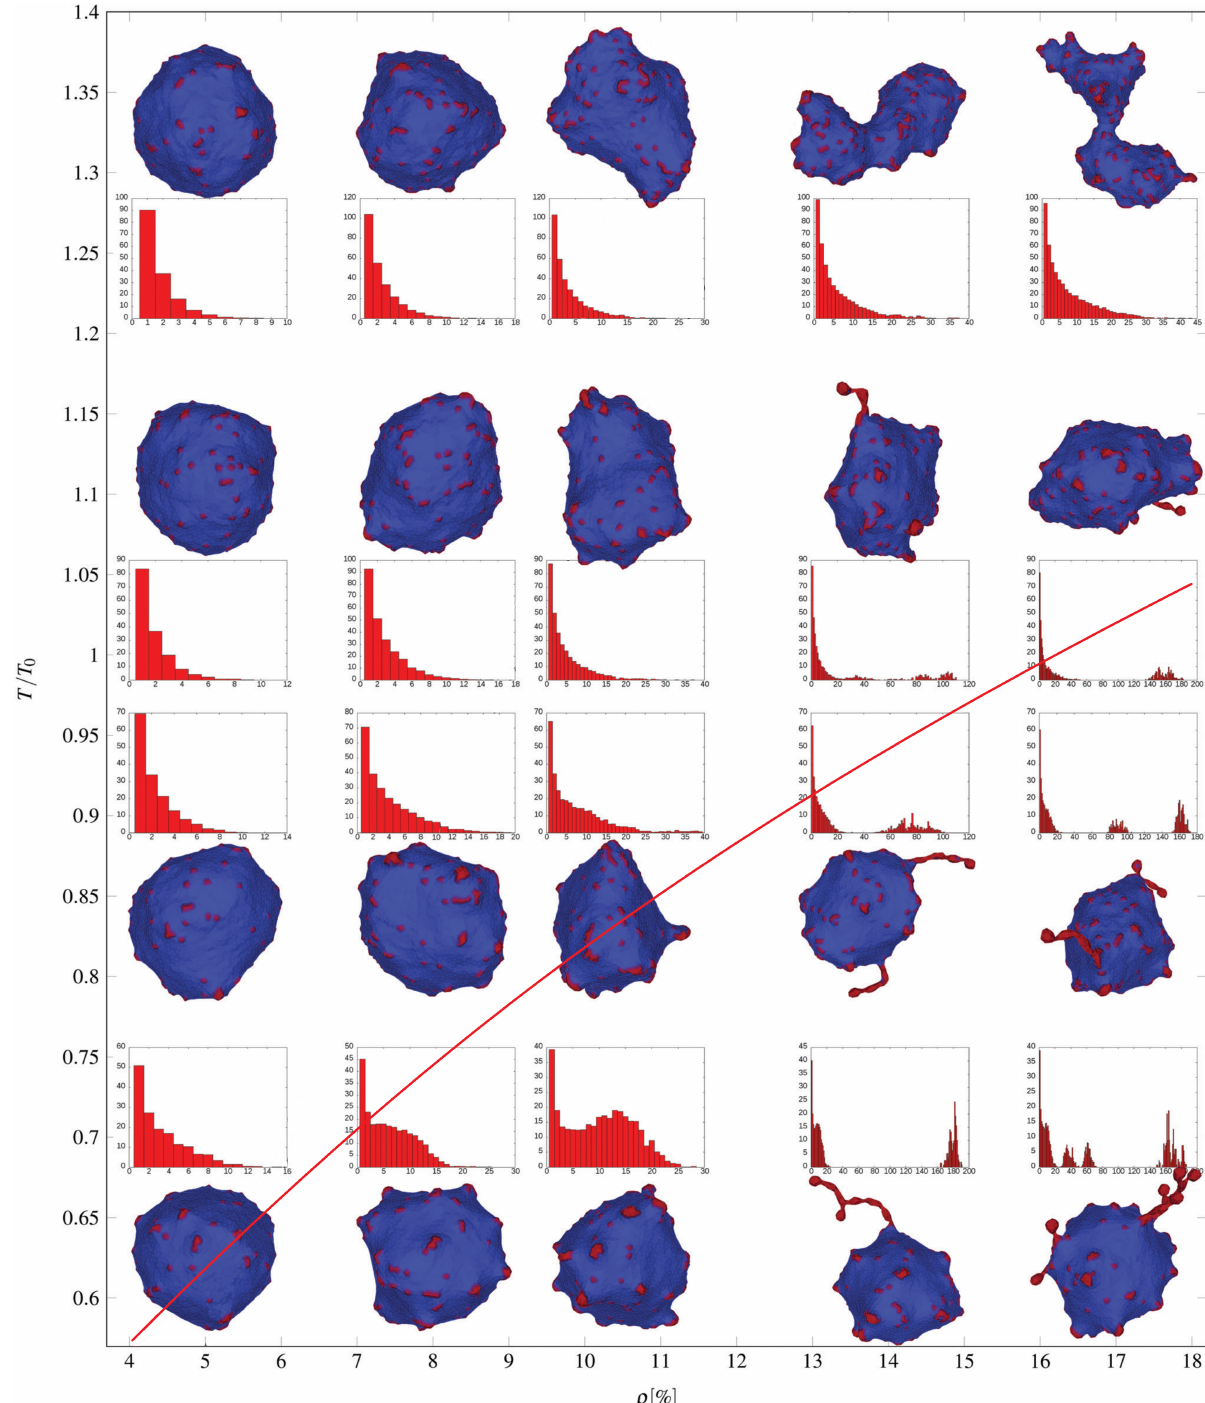
Figure 17. Monte-Carlo (MC) predicted vesicle shapes in thermal equilibrium with curved flexible nanodomains. The dia- gram provides information for differing average densities of curved nanodomains ρ and relative temperatures T / T 0 . Blue surfaces represents the nanodomain-free lipid bilayer and has zero intrinsic (spontaneous) curvature; red surface denotes the curved nanodomain clusters with spontaneous curvature c 0 . In the corresponding cluster-size distributions below each snapshot, the y -axis is the ensemble averaged number of nanodomain clusters and the x -axis is the nanodomain cluster size. The red curve is a boundary between shapes without and with protrusions predicted by the theory of self-assembly. Below it, growth of membrane protrusions is favorable (see Equation (32)). Adapted with permission from ref. [24]. 2019 Royal Society of